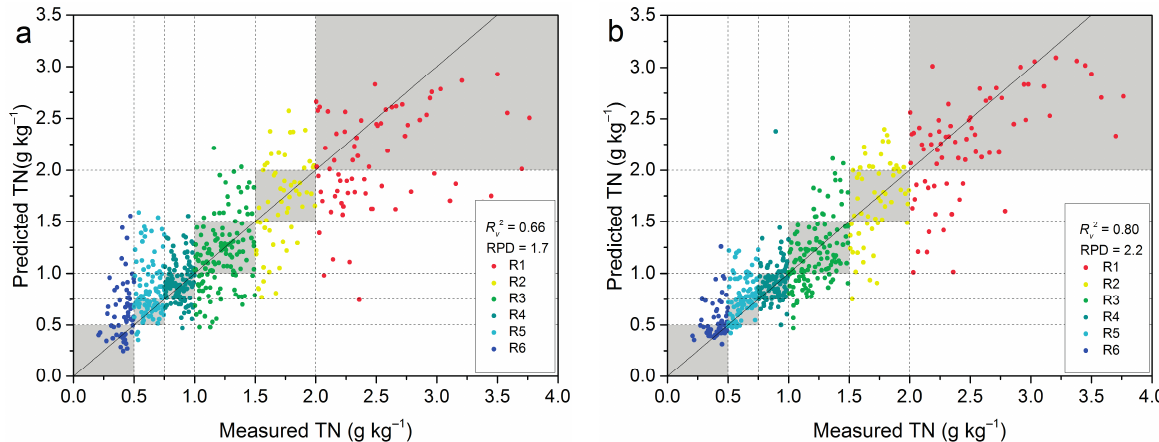
Figure 3. Prediction accuracy of total nitrogen concentrations for 518 samples using the Chinese Soil Spectral Library with PLSR ( a ) and LWR ( b )